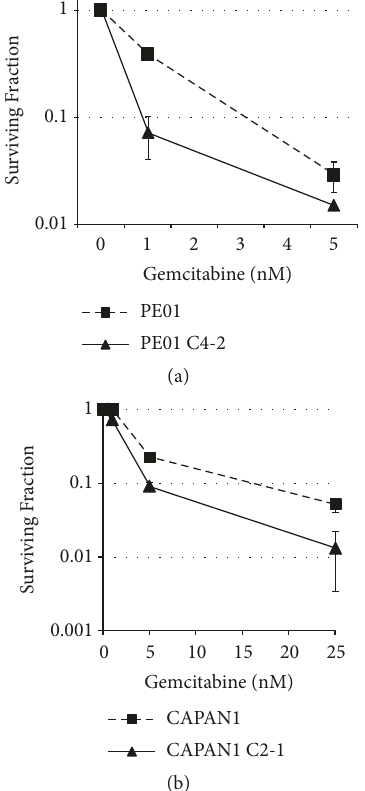
Figure 4: BRCA2 mediates the cytotoxicity induced by gemcitabine . Impact of BRCA2 on the cellular sensitivity to gemcitabine was examined. BRCA2-deficient ovarian cancer cell line PE01 (closed square with dashed line) and pancreatic cancer cell line CAPAN1 (closed square with dashed line) are more resistant to gemcitabine compared to PE01(C4-2) (closed triangle) and CAPAN1 (C2-1) (closed triangle) that regain active BRCA2, respectively. Three independent experiments were performed and averages of surviving fraction are plotted. The error bars show standard deviations. The differences in the gemcitabine sensitivity between PE01 and PE01(C4-2), or CAPAN1 and CAPAN1(C2-1), are statistically signif- icant with p <